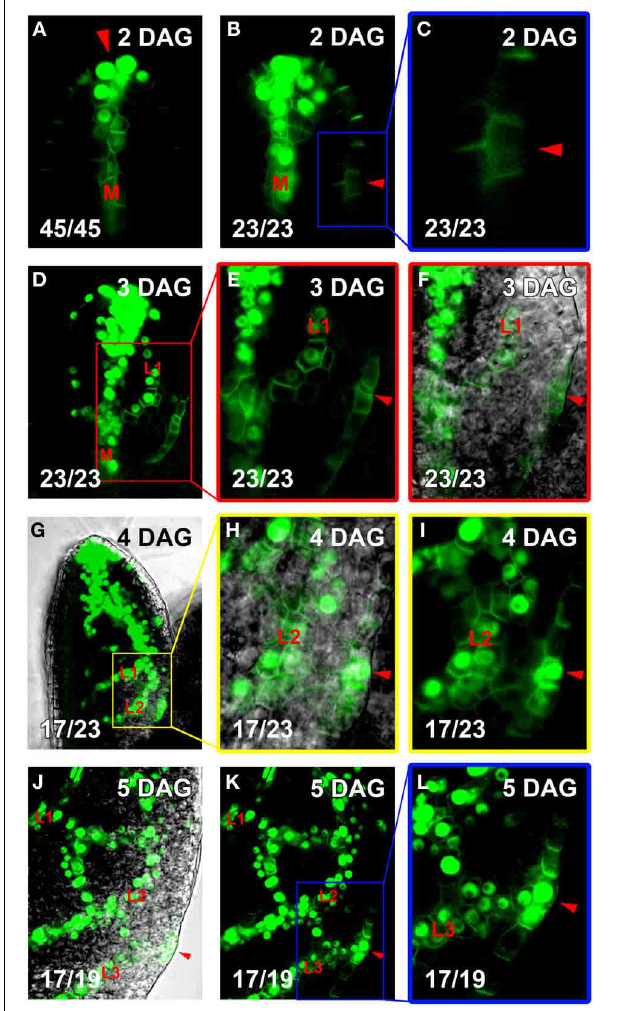
FIGURE 5 | Co-visualization of DR5rev::VENUS:NLS and PIN1:GFP . Top right, leaf age in DAG, bottom left, reproducibility quotient ( Table 2 ). Scale bars: (A–F , H–L) 10 µ m; (G) 20 µ m. (A–C) Expression of DR5rev::VENUS:NLS (nuclear) and PIN1:GFP (plasma membrane). Note strong DR5rev at apical convergence point (CP, red arrowhead in A ) and midvein (labeled M in A,B ), but faint DR5rev in lateral CP the first loop (red arrowhead in B , enlarged in C ). (D,E) At 3DAG, extension of DR5rev to first loop PED (labeled L1 in D–F ). Red-boxed area in D enlarged in (E,F) , with DIC channel overlay in (F) . Lateral CPs marked by red arrowheads in (E,F) . (G–I) At 4DAG, extension of DR5rev expression to second loop PEDs (labeled L1 and L2, respectively, in G–I ). Yellow-boxed area in (H,I) , with DIC channel overlay in (H) . DR5rev expression now present in the lateral CP (red arrowheads in H,I ). (J–L) At 5 DAG, DR5rev extension to third loop PEDs (labeled L1, L2, and L3, respectively, in J–L ). The same leaf area shown in (K) with DIC channel overlay in (J) . Blue-boxed area enlarged in (L) . DR5rev expression lateral CP of third loop (red arrowheads in J–L ).